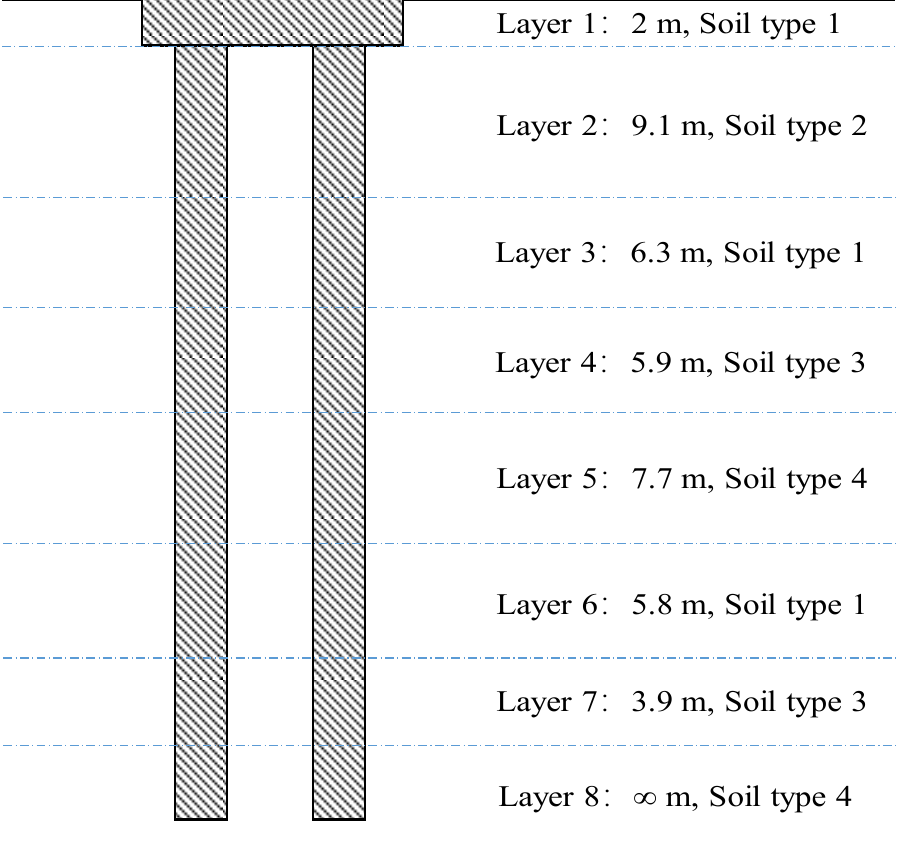
Figure 8. Distribution of the soil layers. Table 2. Parameters of the 2 × 3 pile-group